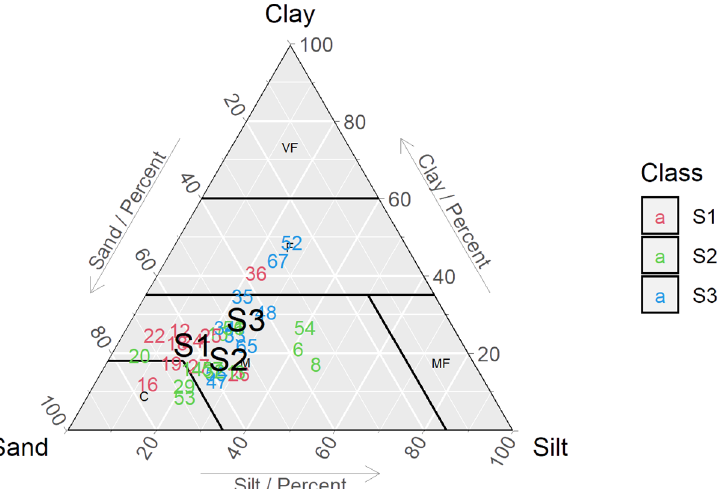
Figure A1. Classification of soil samples according to the FAO Soil Map of Europe classification [77]. Soil sample classes S1, S2 and S3 are denoted by red, green and blue markers, respectively. Annotations S1, S2 and S3 indicate the mean soil texture for each class.